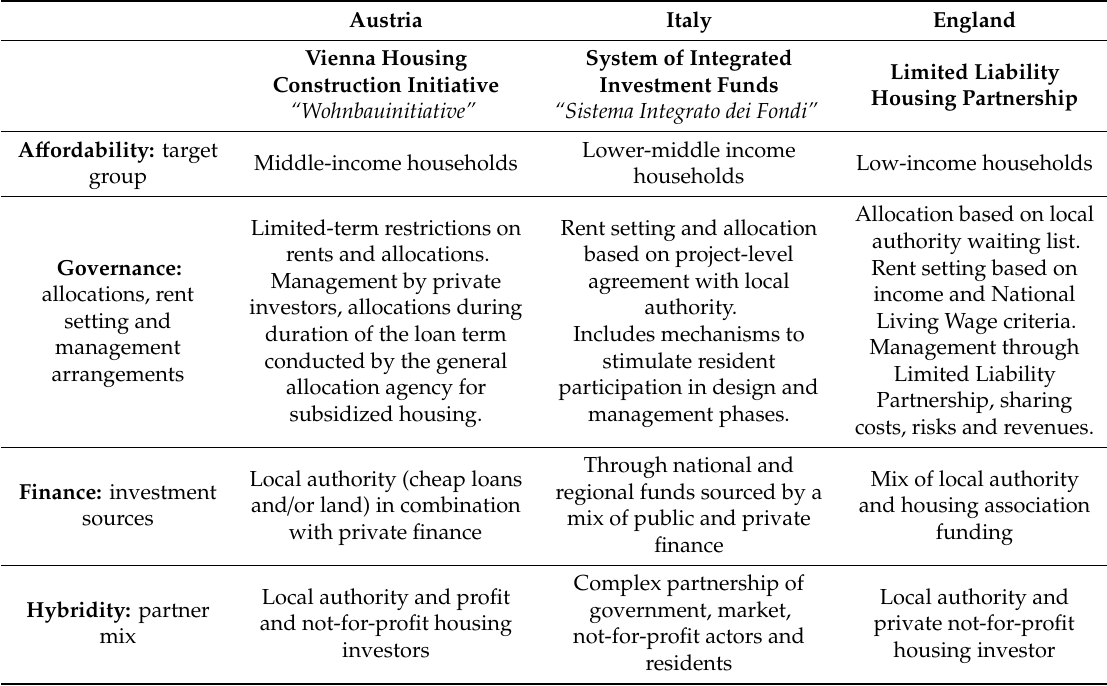
Table 1. Overview of the three case studies.